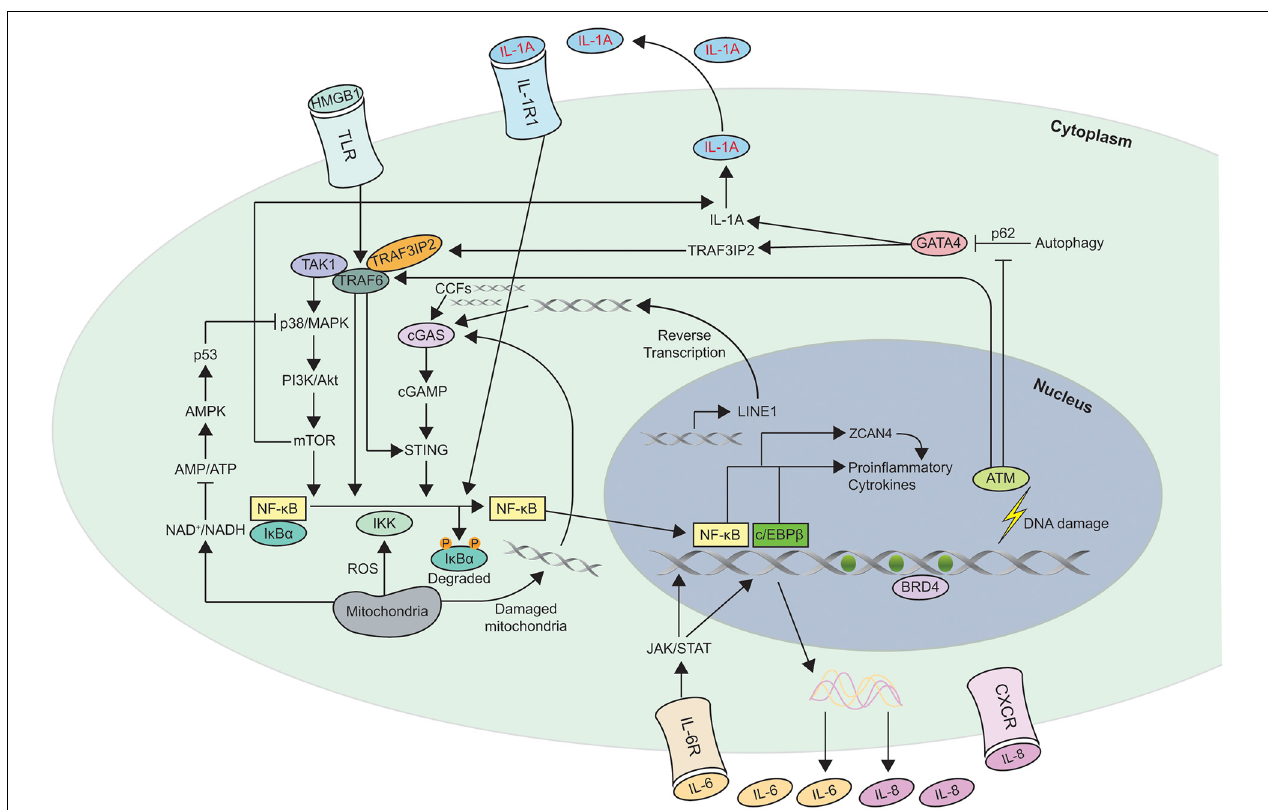
FIGURE 2 | Schematic of the different mechanisms involved in Senescence Associated Secretory Phenotype (SASP) regulation. This figure shows the different pathways involved in regulating SASP. Most of the pathways converge to activate the transcription factors NF- κ B and c/EBP β in senescent cells. The autocrine feed forward signaling of different pro-inflammatory cytokines such as IL-1A, IL-6, and IL-8 is illustrated. ZCAN4 promotes the expression of inflammatory cytokines via NF- κ B. TAK1 activates p38/MAPK, a kinase that subsequently engages PI3K/Akt/mTOR pathway. mTOR is capable of activating the NF- κ B signaling directly as well as indirectly via IL-1A. GATA-4 links autophagy and DNA damage response to SASP via IL-1A and TRAF3IP2. NAD + , ROS, and DNA from damaged mitochondria are also involved in regulating SASP. Increase in transcription of LINE-1, a retrotransposable element in senescent cells facilitates accumulation of cDNA in the cytoplasm which leads to the activation of cGAS/STING pathway. In addition to LINE-1, CCFs, and DNA from damaged mitochondria are recognized by cGAS to generate cGAMP which subsequently activates STING to induce expression of SASP factors. The triggers for SASP activation can originate within the cell such as DNA damage, CCFs, cytosolic DNA or act on membrane receptors such as HMGB1, IL-1A, IL-6, and IL-8. Degradation of the inhibitor I κ B α which sequesters NF- κ B in cytosol, leads to nuclear translocation of NF- κ B leading to expression of SASP genes. Recruitment of the chromatin reader BRD4 to newly activated super-enhancers adjacent to key SASP genes is needed for the SASP and downstream paracrine signaling. CCFs, cytoplasmic chromatin fragments; ROS, reactive oxygen